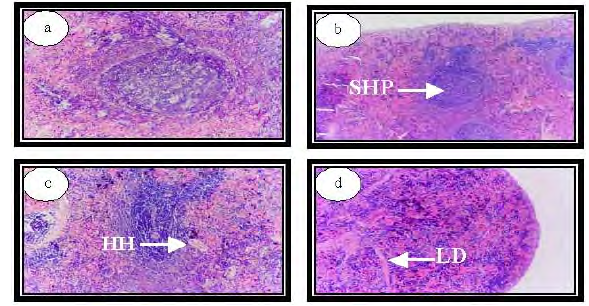
Figure 11 : Histopathology of spleen from female rats treated with saline (a) showing normal splenic tissue; AcAaIT (b) showing scattered hemosidrin pigment (SHP) in the splenic red pulps; AcMNPV (c) showing mild hyperplasia of white pulps and hemosidrosis (HH); and SlNPV (d) showing mild lymphoid depletion (LD) (H&E